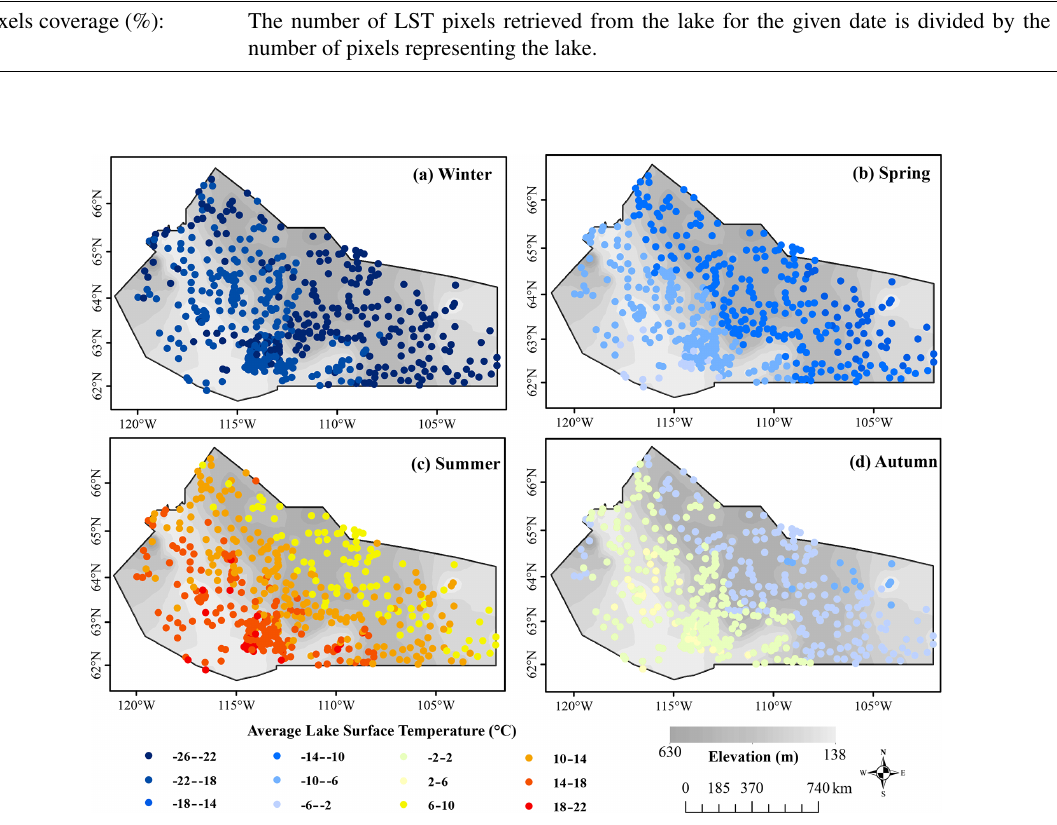
Figure 10. Spatial distribution of average LST of all years across the NSR for (a) winter, (b) spring, (c) summer, and (d) autumn.